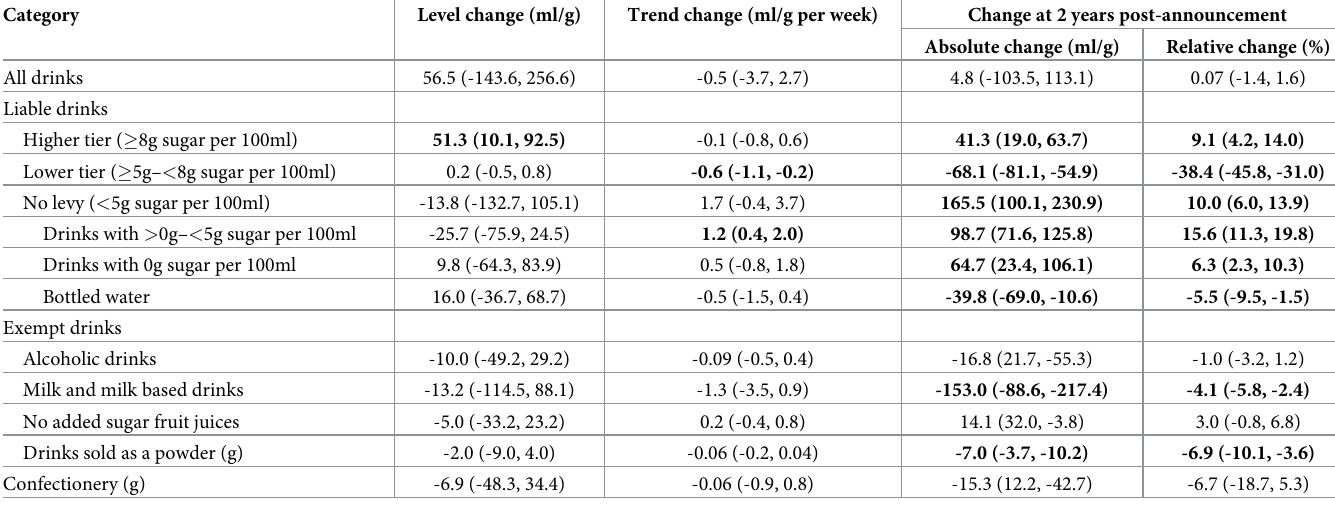
counterfactual at the first week after the SDIL announcement controlling for the underlying trends in household purchases through purchases of toiletries. The trend change is the mean change in the slope of purchases following the announcement. The absolute and relative differ- ences represent the difference between the counterfactual and the model estimates in the final week of the study. Results are displayed graphically in Figs 1 and 2 for levy eligible drinks and Table 2. Adjusted change in mean volume of drinks (ml) and confectionery (g) purchased per household per week (95% CI) (level) and adjusted change per week (trend) post-announcement of the Soft Drinks Industry Levy including toiletries as a control condition, with absolute and relative differences in purchased volume at two-years